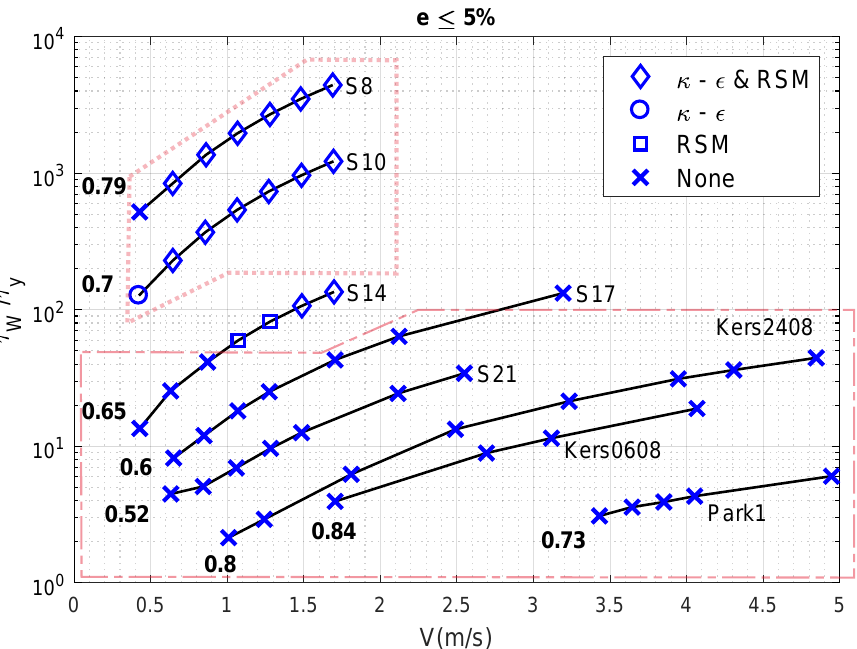
Figure 9. Performance of the standard RANS models to achieve an error e ≤